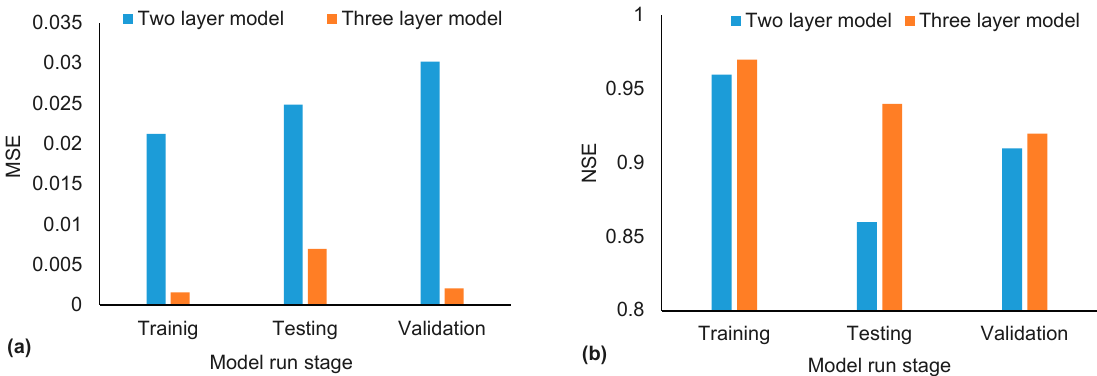
Figure 10. Comparison of ANN results for two- and three-layer architecture models with 10 neurons in each layer; ( a ) MSE values, ( b ) NSE values.